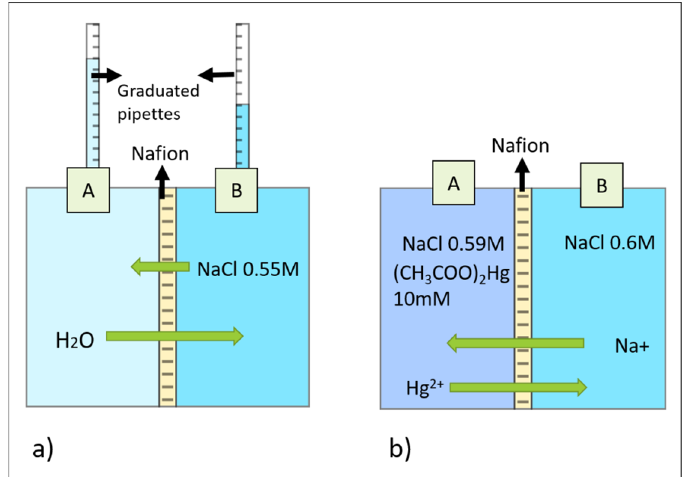
Figure 3 . ( a ) Diffusion cell used to measure water and Na + mass transfer coefficients in Nafion ® ; ( b ) diffusion cell used to measure Hg 2+ mass transfer coefficient in Nafion ® .